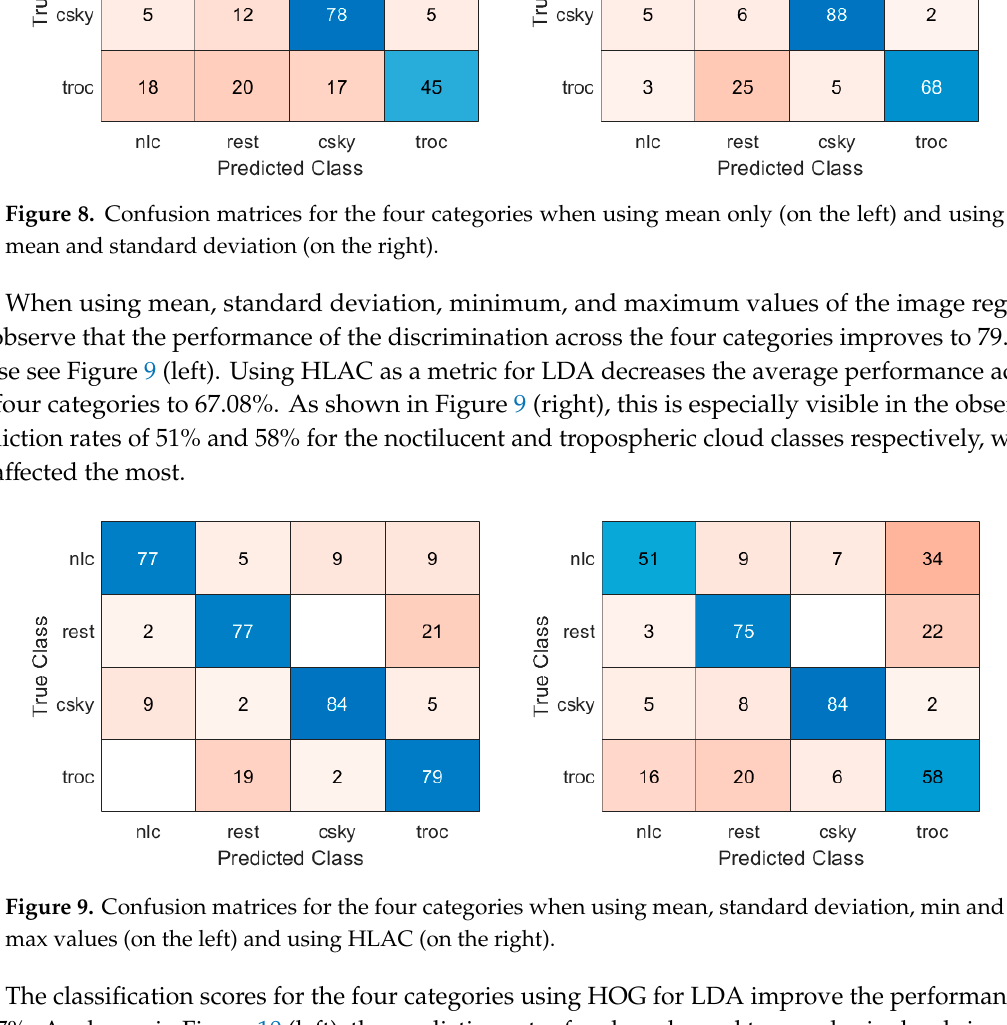
Figure 10. Confusion matrices for the four categories using a histogram of oriented gradients (HOG) (on the left) and when using the proposed CNN based approach (on the right).